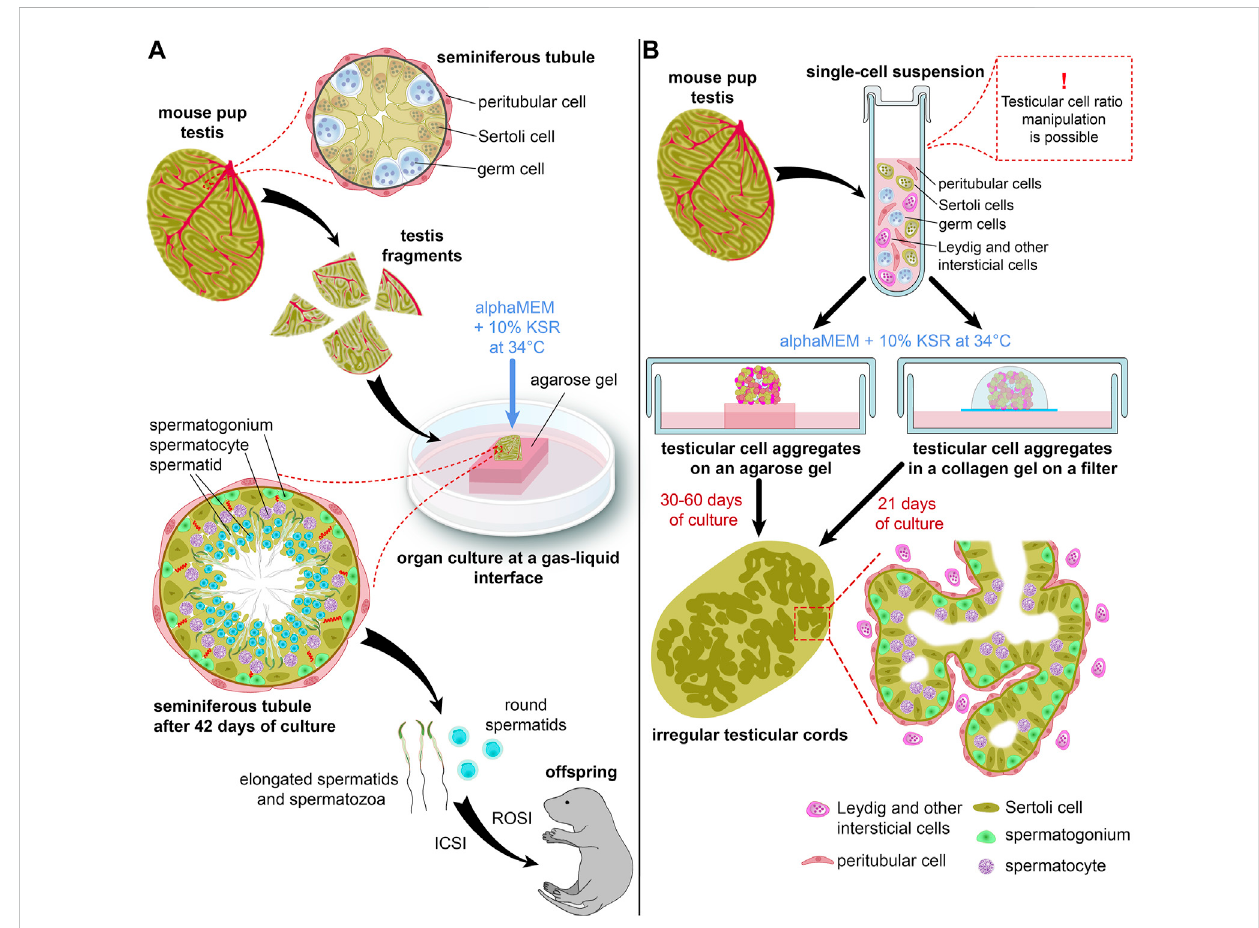
FIGURE 1 Schematic representations of an organ culture method (A) and a 3D-culture method (B) for in vitro spermatogenesis. (B) shows two types of 3D- culture producing more advanced germ cells.